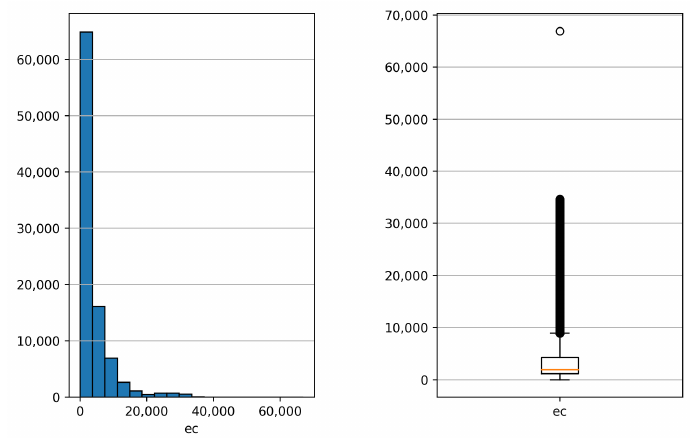
Figure 12. Electric conductivity histogram and boxplot.